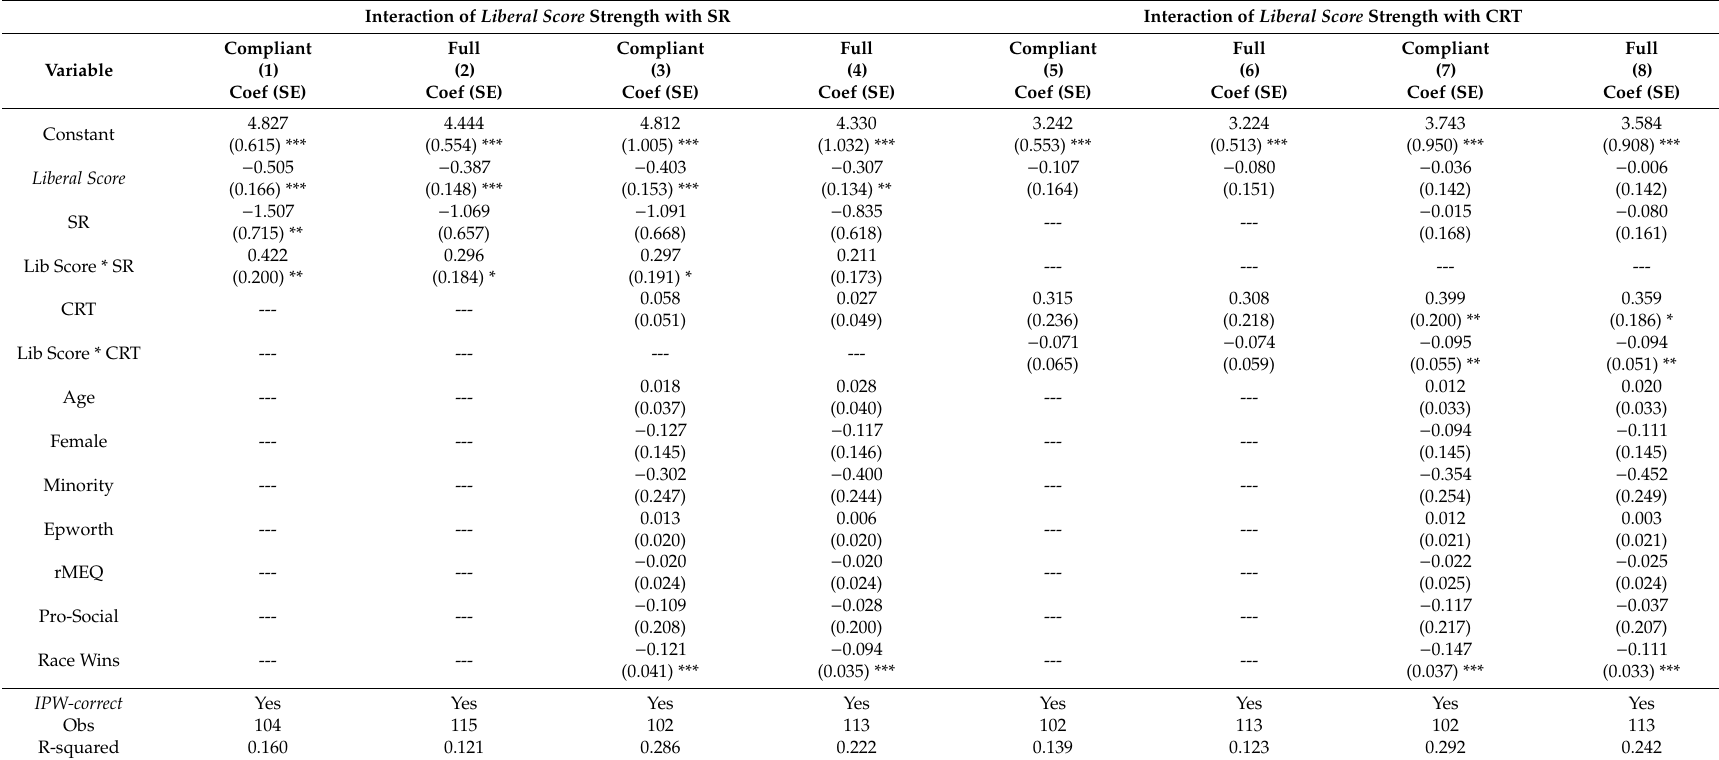
Table 6. Impact Liberal Score and interactions on # PRO-GUN-RIGHTS CLIPS